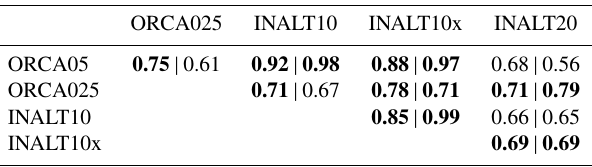
Table 9. Correlations of AMOC time series at 34.5 ◦ | 26.5 ◦ N based on annual averages. Significant correlations at 99% confidence level are given in